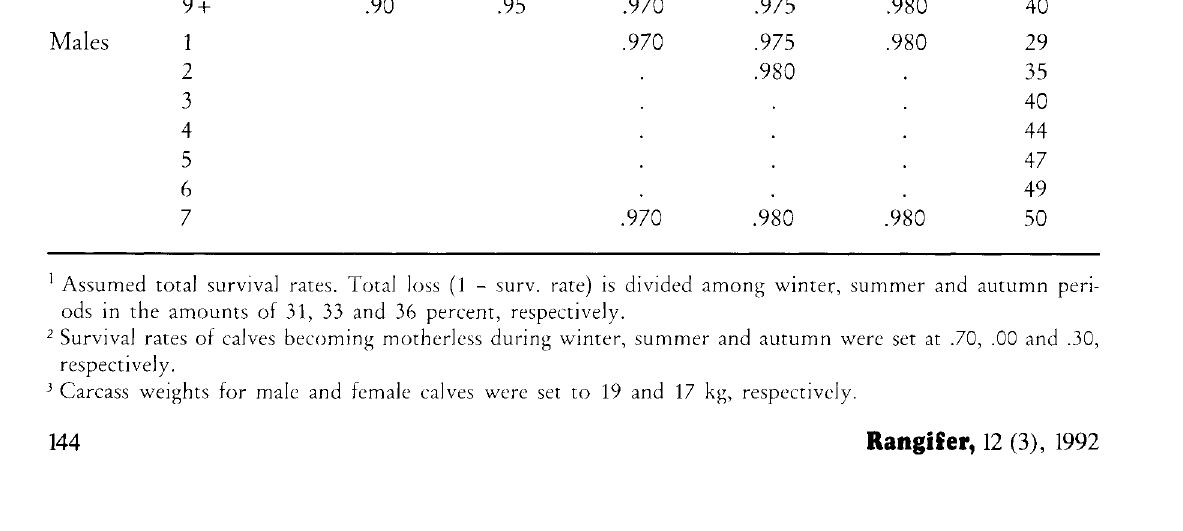
Table 1. Assumed calving rates, survival probabilities and carcass weights (kg). The parameters are based main